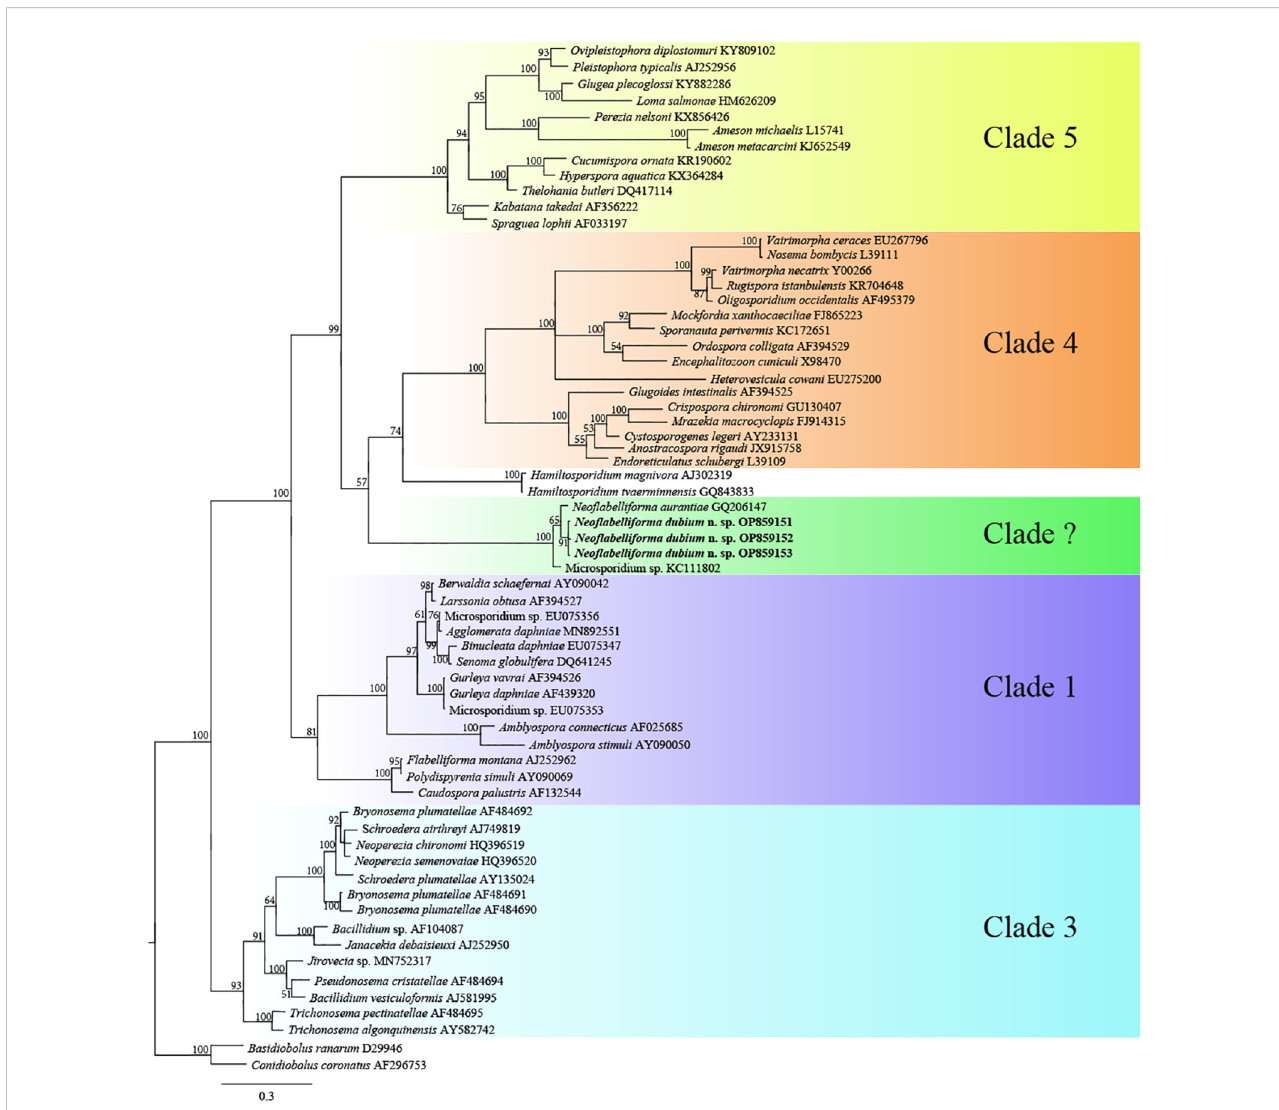
FIGURE 4 The SSU rDNA-inferred phylogenetic tree of Neo fl abelliforma dubium n. sp. and the other aligned microsporidian species by Bayesian Inference method. Posterior probabilities were shown on branch nodes. The present species was indicated in